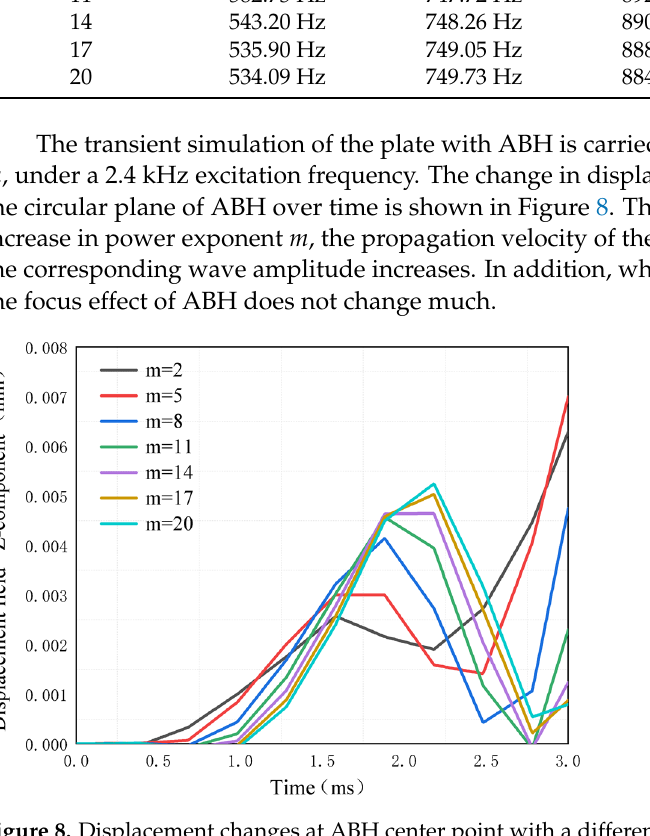
Figure 8. Displacement changes at ABH center point with a different power index.